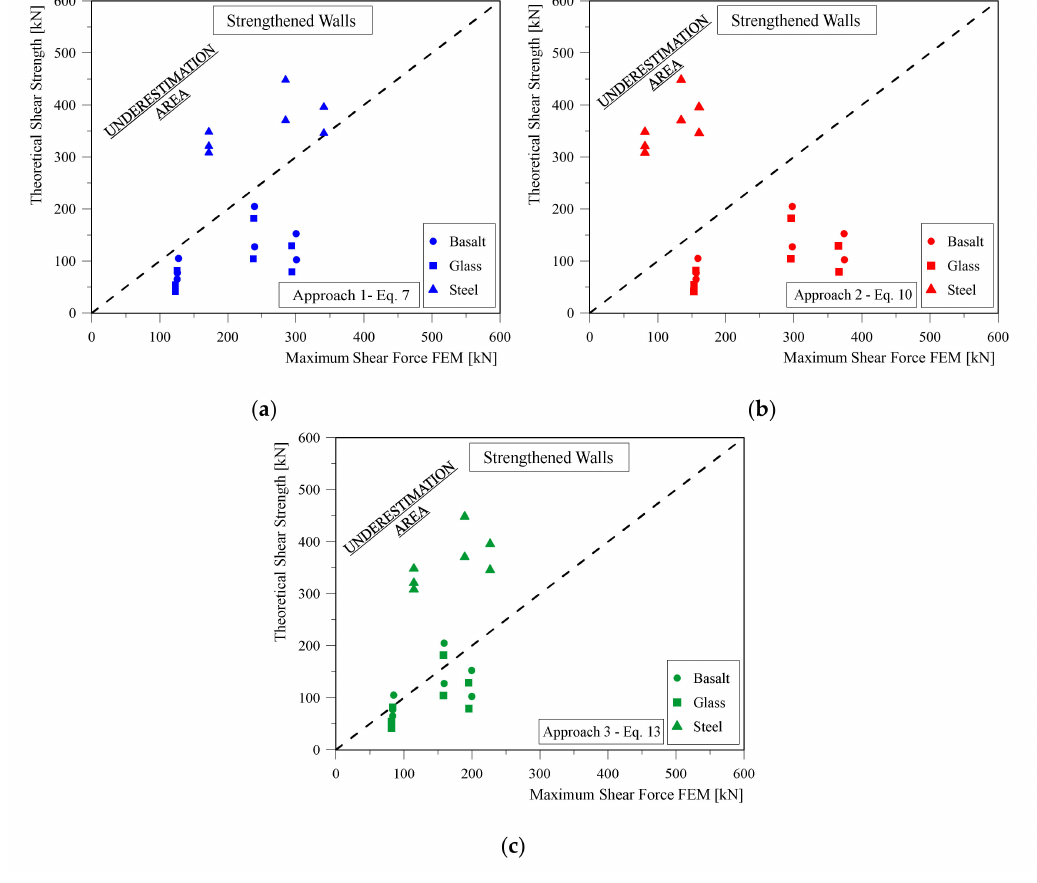
Figure 4. Theoretical shear strength vs. FEM predictions for strengthened walls: ( a ) Approach 1; ( b ) Approach 2; ( c ) Approach